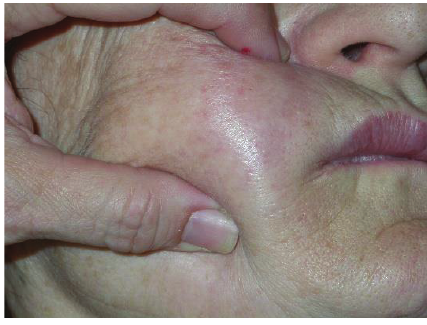
Figure 2: Granuloma 3 ∗ 3 cm located in supraciliary area, right side.